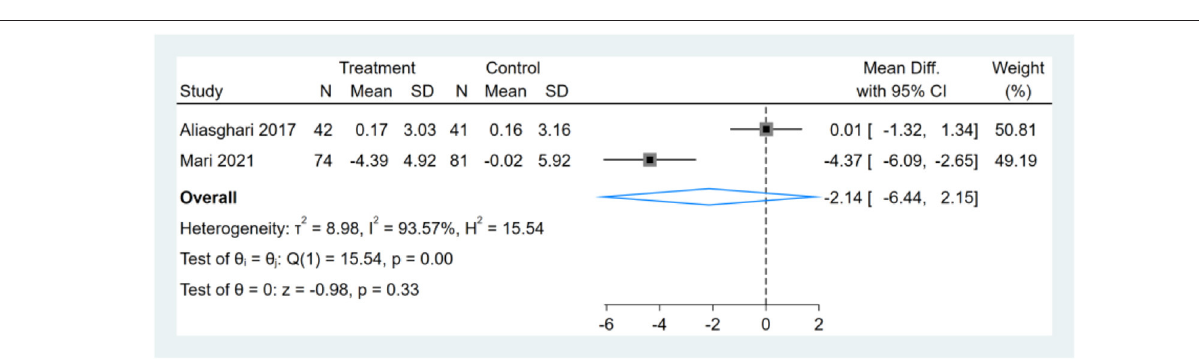
FIGURE 7 | Forest plot analysis showing changes in fasting insulin (FINS).